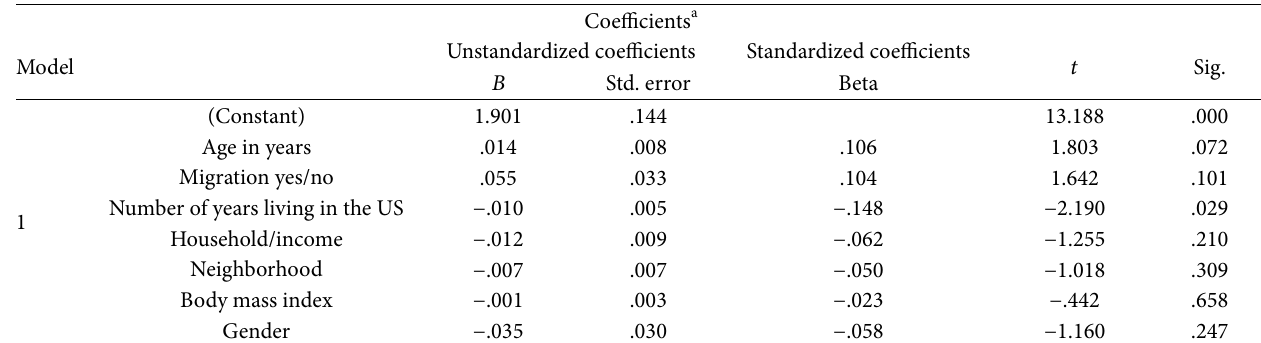
Table 4: Predictors of